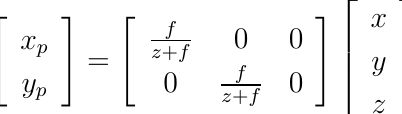
, y , 0) on the projection plane P P P